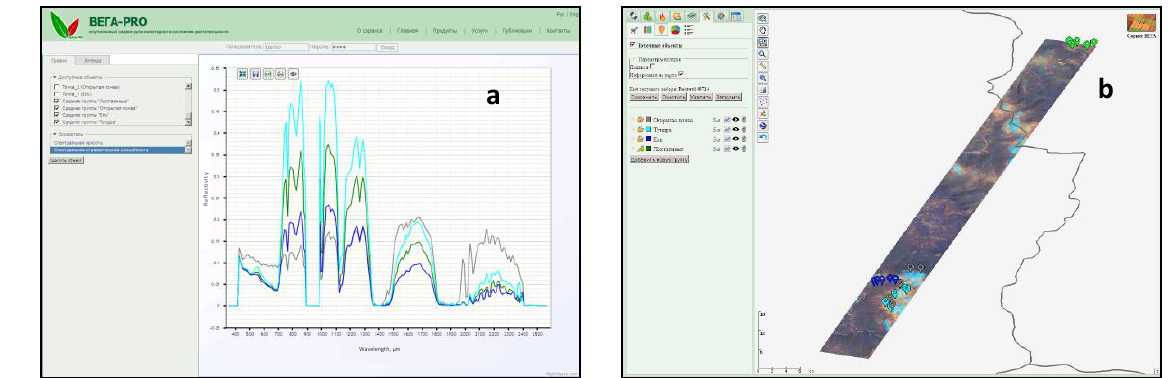
Figure 12. Spectral portraits (a) of vegetation types of deciduous forest (green), spruce (dark blue), tundra (blue), bare soil (dark grey) and their location on terrain